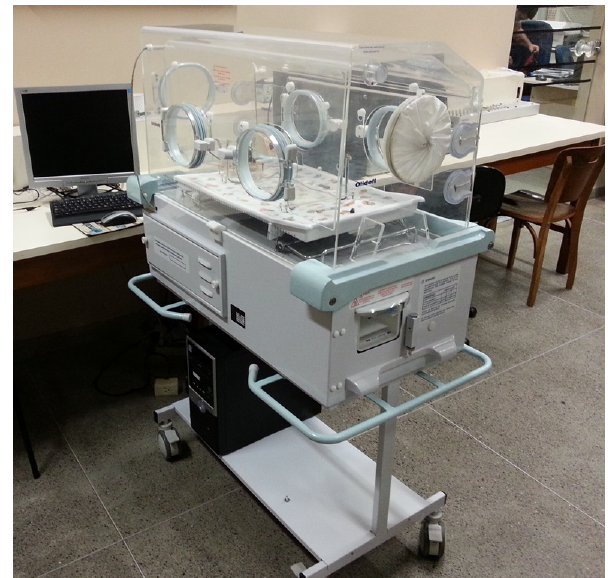
Figure 1. Example of a commercial incubator.